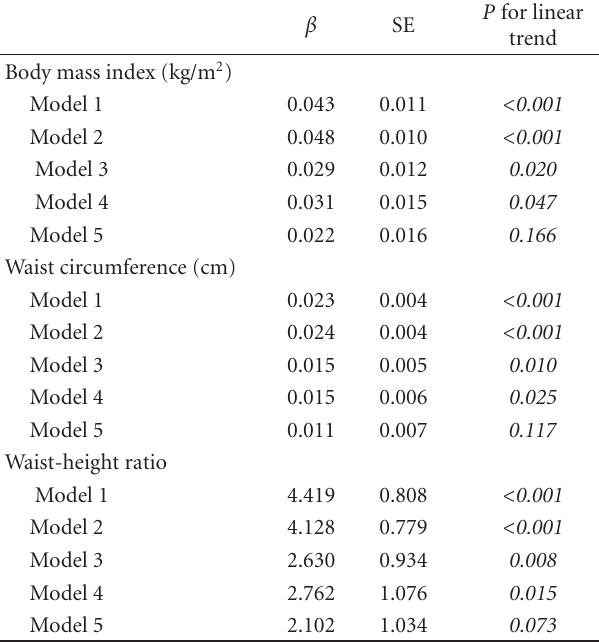
Table 3: Regression coe ffi cients ( β ) with standard errors (SEs) for suicidal ideation among US women aged ≥ 20 years by continuous BMI, waist circumference, and waist-height ratio ∗ , NHANES 2005–